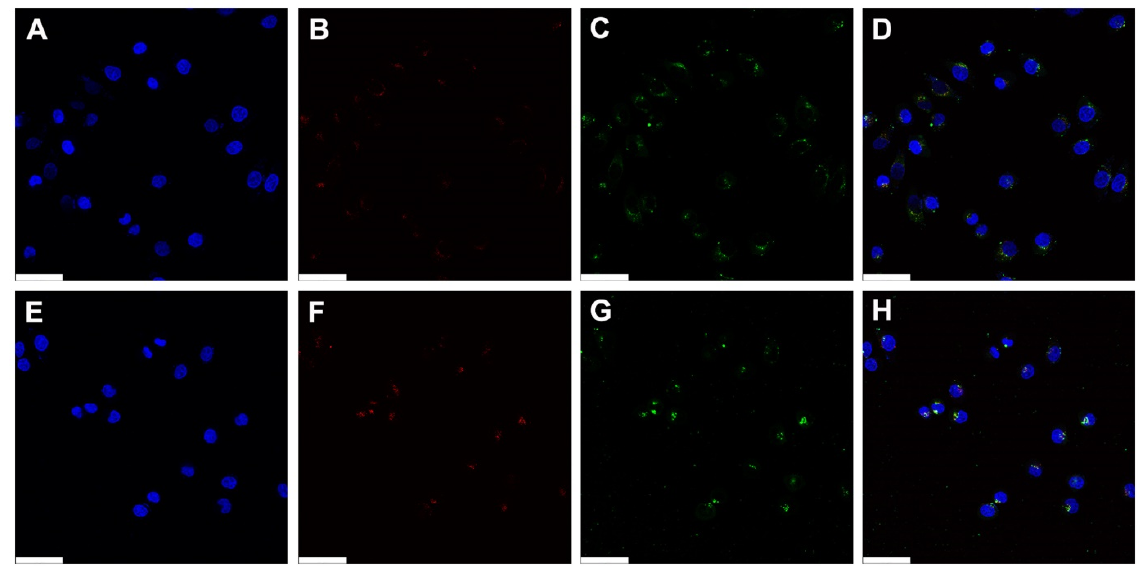
Figure 6. CLSM images of PEI25k polyplexes ( A – D ) and HECP2k 10X polyplexes ( E – H ) in HeLa cells. DAPI (blue) stained nuclei ( A , E ) and Lysotracker red DND-99 (red) stained acidic organelles ( B , F ). pDNA was labeled using YOYO-1 (green, ( C , G )). ( D , H ) show merged images (scale bar = 50 μ m). After 4 h of treatments, cells were visualized after 4 h of further incubation.